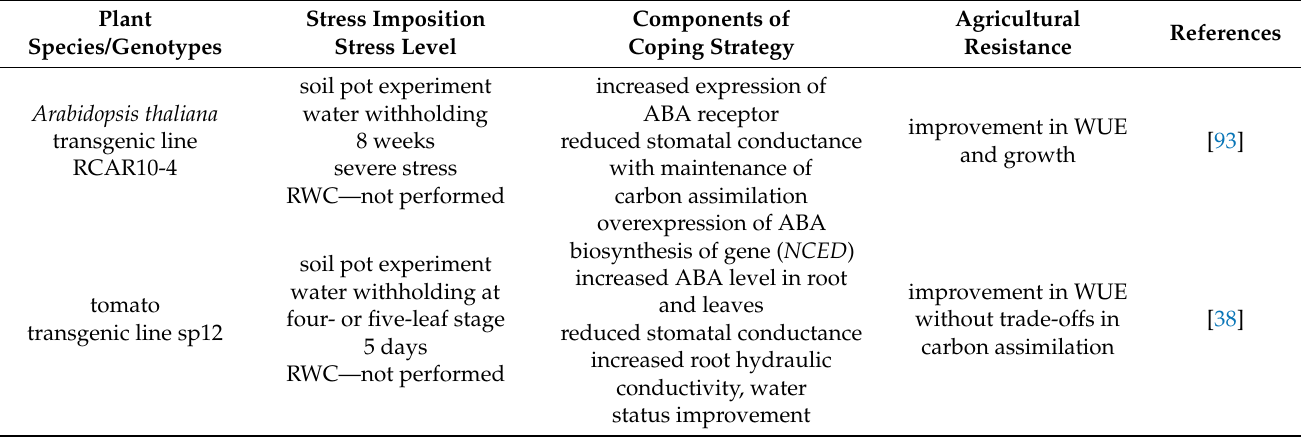
Table 1. Components of coping strategies and agricultural resistance in crops and model